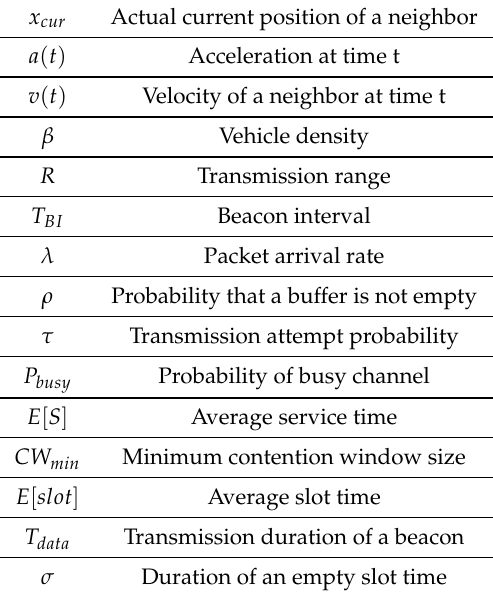
Table 1. Notation for the mathematical